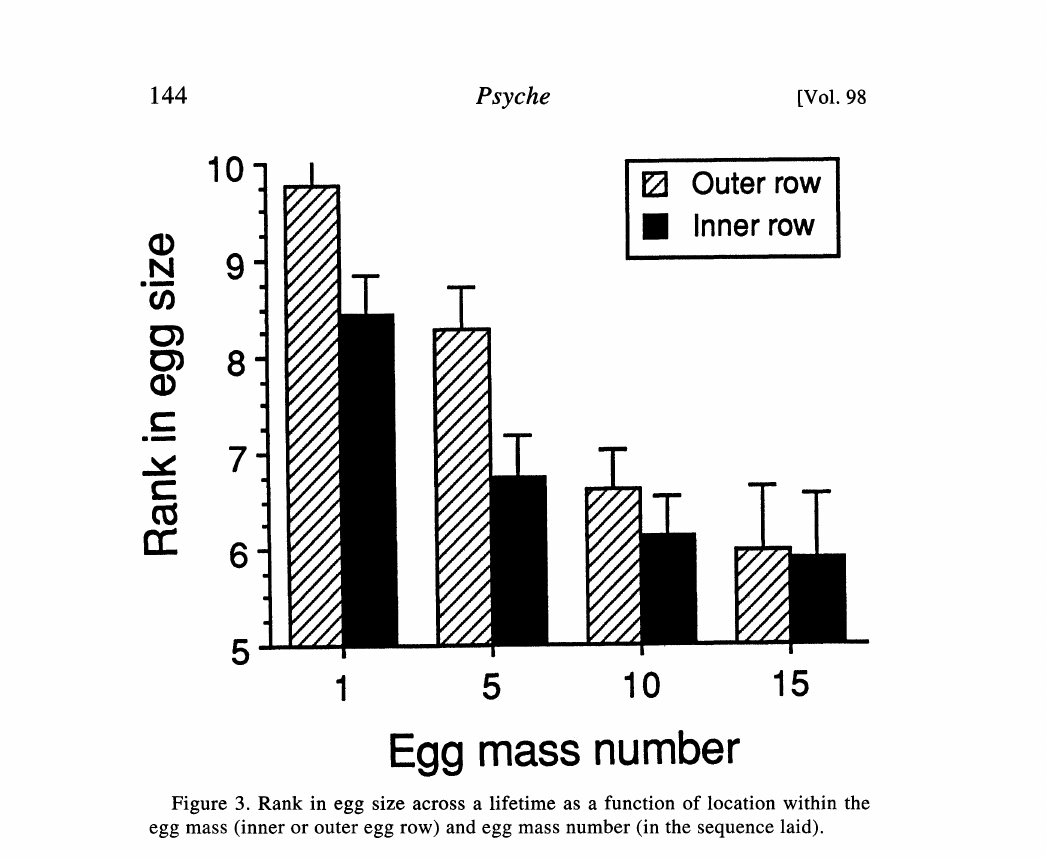
Figure 3. Rank in egg size across a lifetime as a function of location within the egg mass (inner or outer egg row) and egg mass number (in the sequence laid). For both males and females, egg size within an egg mass was significantly positively correlated with adult size and significantly negatively correlated with development time (Table 4; Fig. 4 and 5). The effect of egg size on adult size differed by sex (i.e. inter- cept of the regression was higher in females; F=28.80; df=l,111; P=0.001 in ANCOVA model: adult size constant + egg size + mother + sex). Both egg size (F=42.85; df=l,lll; P<0.001) and mother (F=2.88; df=9,111; P=0.004) had significant effects in